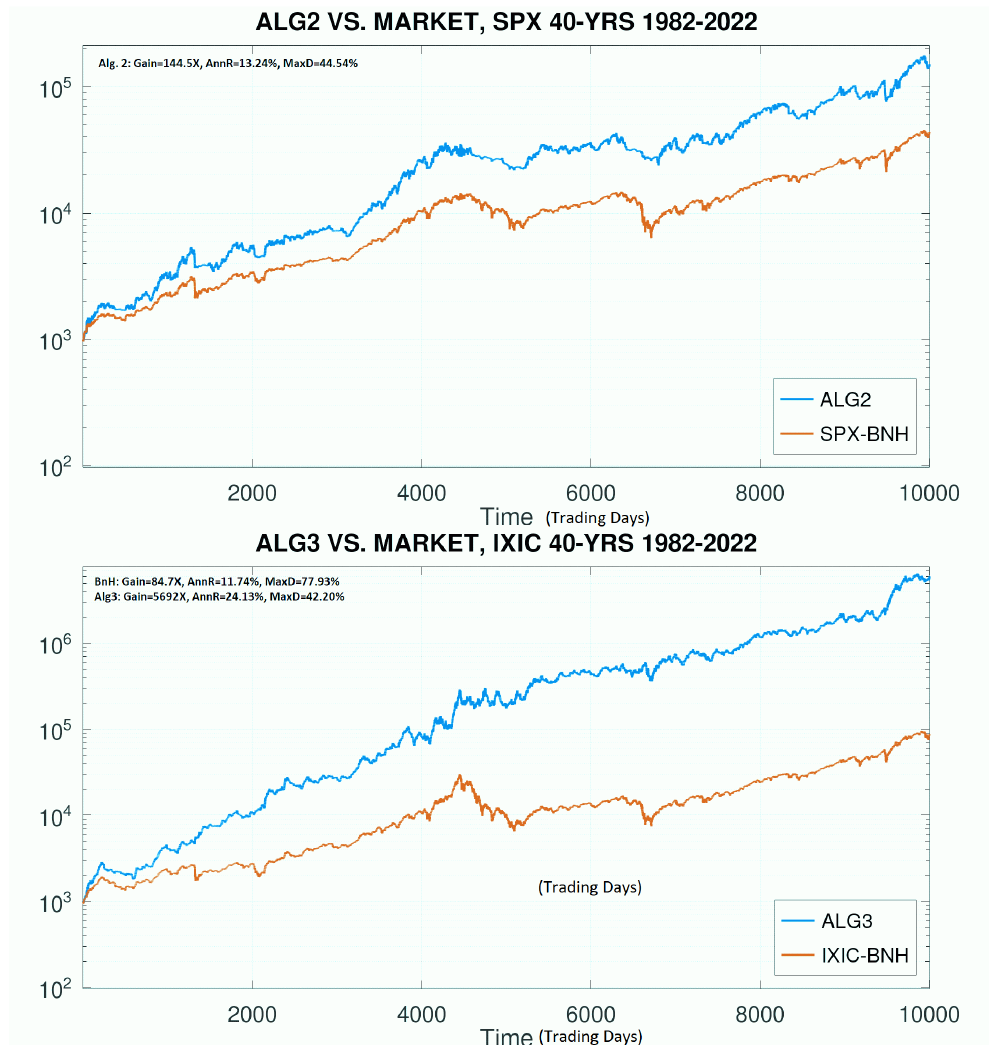
Figure 3. Performance of more sophisticated algorithms on SPX and IXIC, still based on the same set of ideas, which deliver strong performance, yet limited and improving drawdowns. Since these time periods include several major market events, including the Black Swans, these results indicate that fairly elementary algorithms can indeed deliver powerful investment results, which may be applicable to both professional and individual small